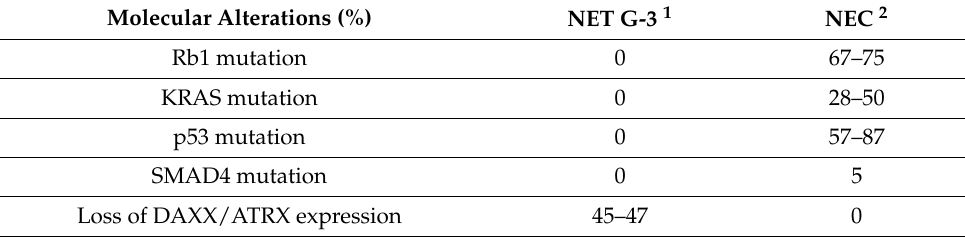
Table 3. Main molecular alterations found in grade 3 neuroendocrine tumors (NET G-3) versus neuroendocrine carcinoma